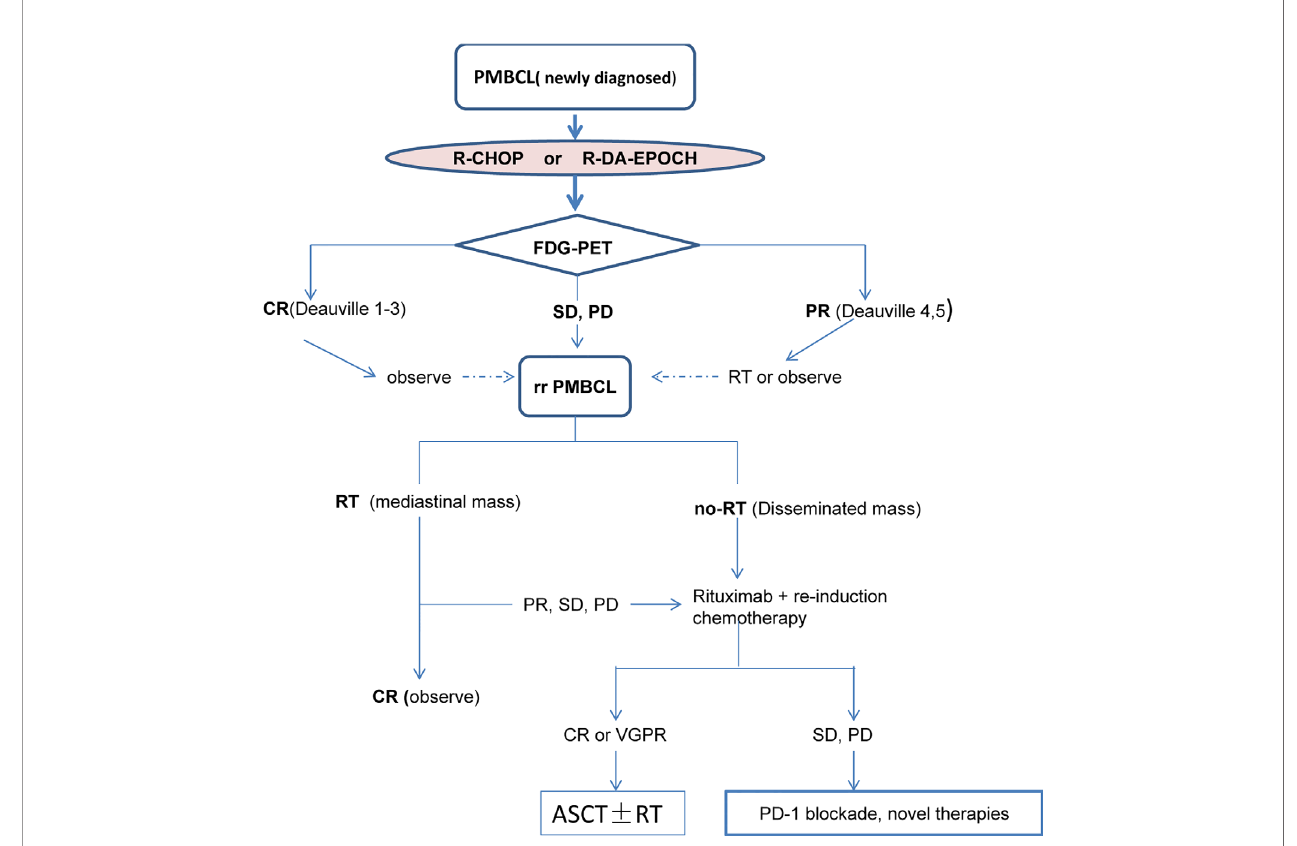
FIGURE 2 | The current routine procedure of clinical treatment of